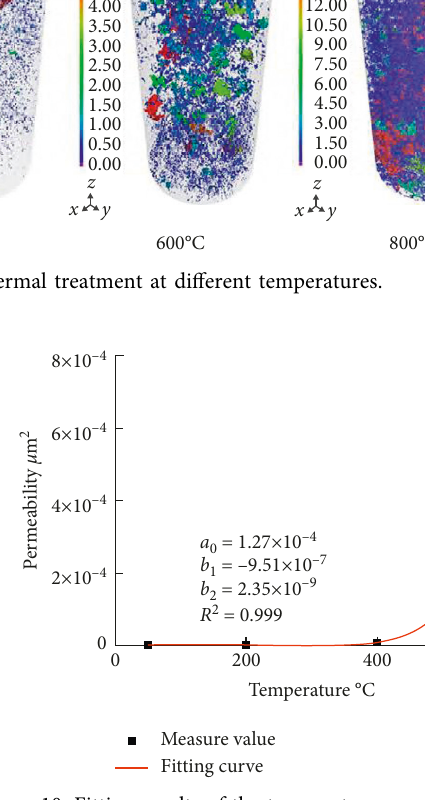
Figure 10: Fitting results of the temperature-permeability